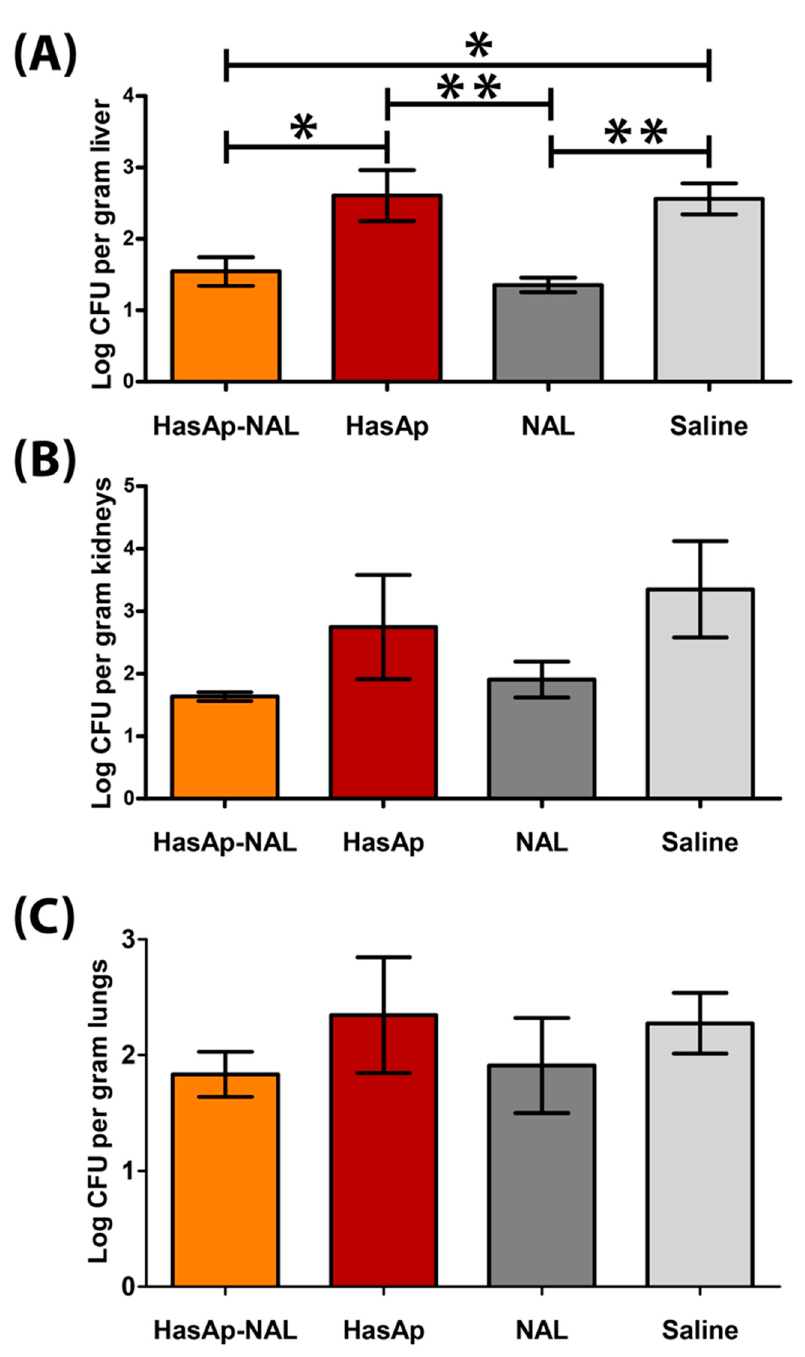
Figure 6. Bacterial burden of PA in livers ( A ), kidneys ( B ), and lungs ( C ) of challenged mice. Error bars represent mean ± SE (standard error of the mean). *: p -value ≤ 0.05, **: p -value ≤ 0.01. One-way analysis of variance (ANOVA) was used followed by Tukey’s test for post hoc analysis.